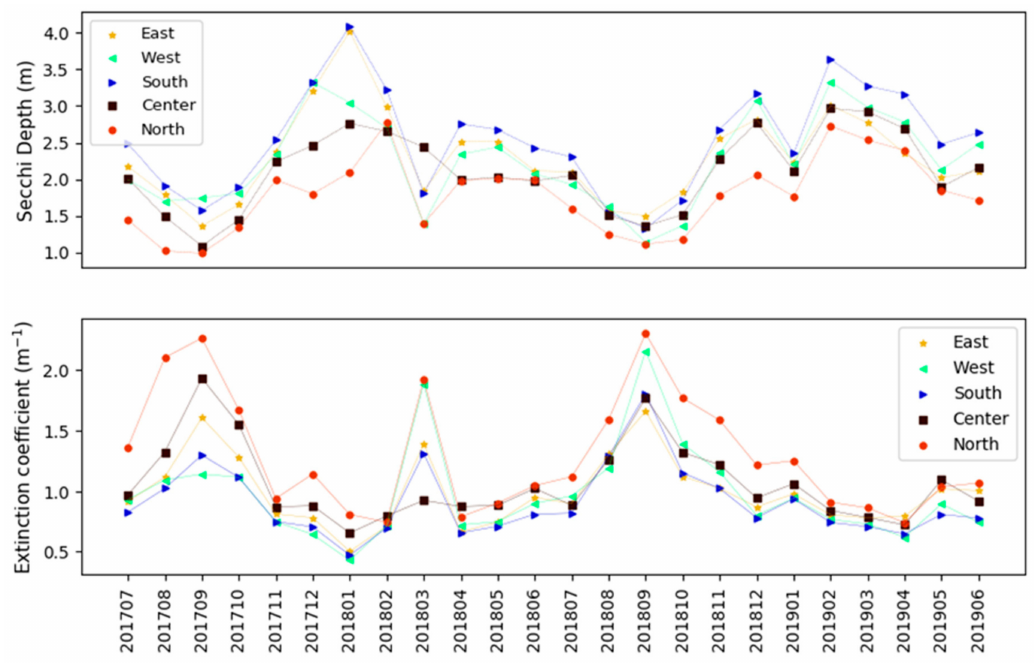
Figure 11. Monthly average of SD (top) and KD (bottom) for each reservoir region.